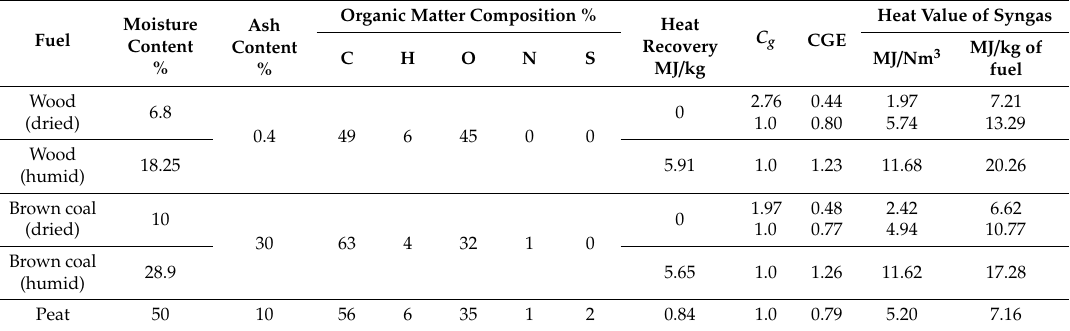
Table 3. Limit characteristics of gasification of some low-grade